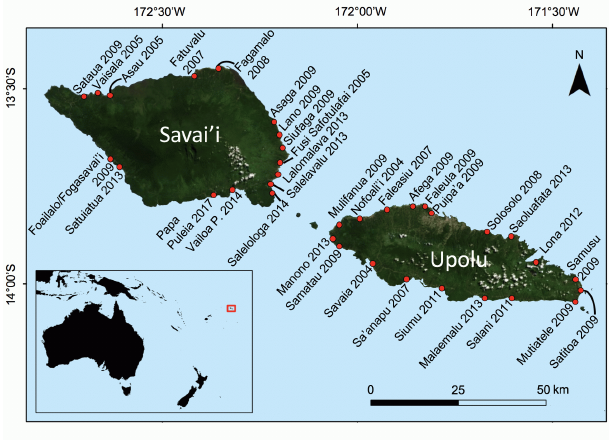
Fig. 1 . Map of Samoa showing locations of the 34 study villages in which fishers were interviewed (red